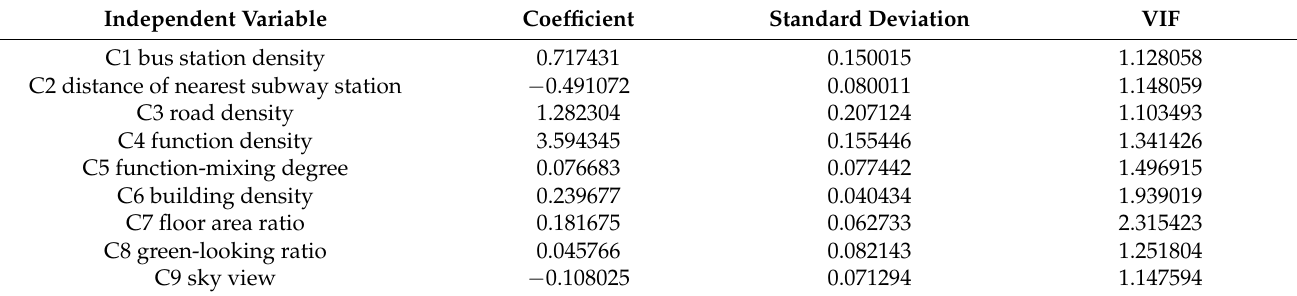
Table 4. Regression coefficients of independent